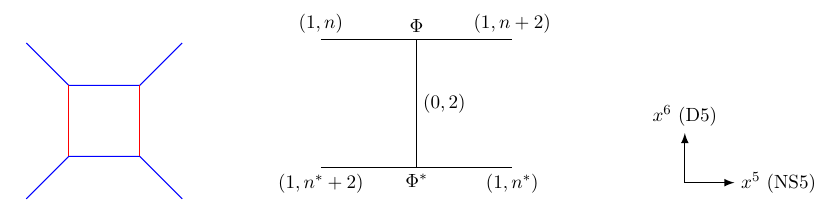
Figure 1 . ( p; q )-web diagram of 5d N = 1 pure U(2) gauge theory (left) and corresponding DIM representations web